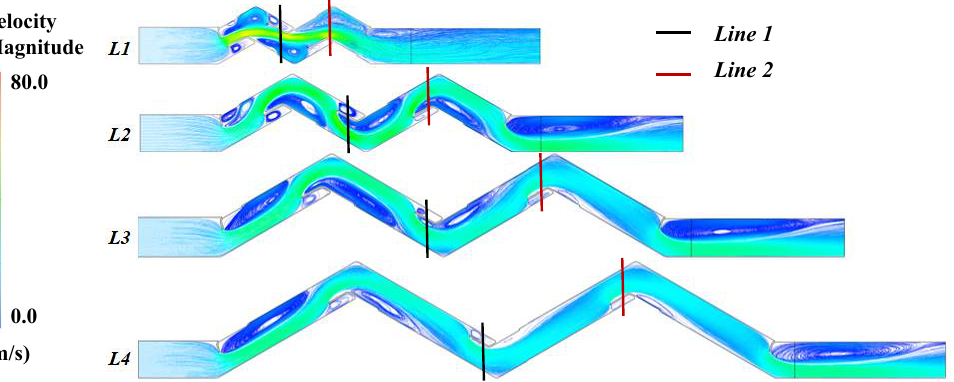
Figure 7. Streamline contour colored by velocity magnitude under inlet velocity U g = 12.00 m/s in different